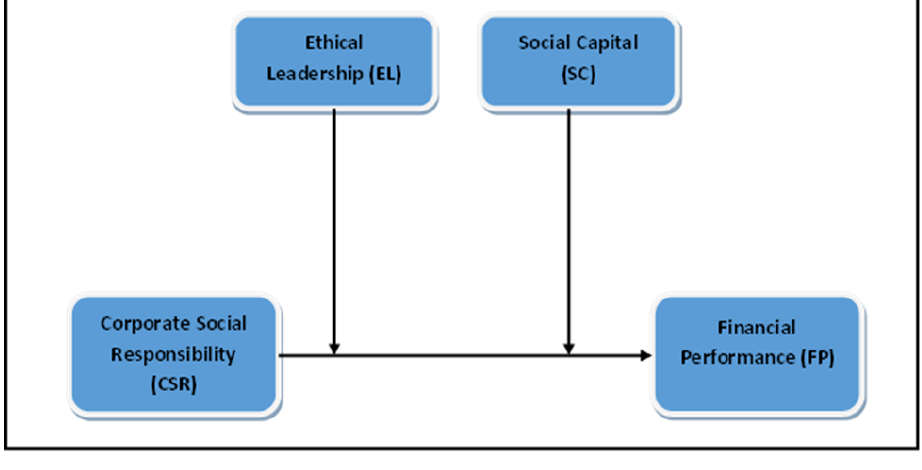
Figure 1: Conceptual